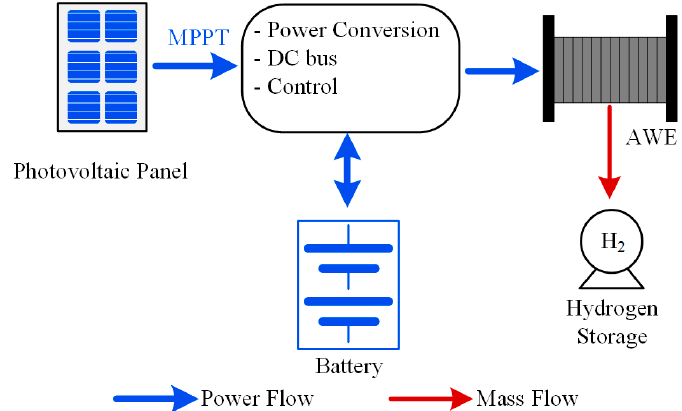
Figure 1. Schematic representation of the system.